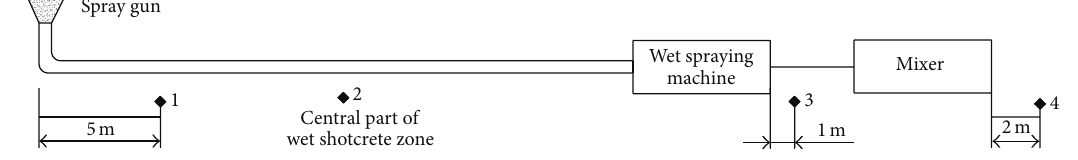
Figure 9: The sampling points for measuring the dust.